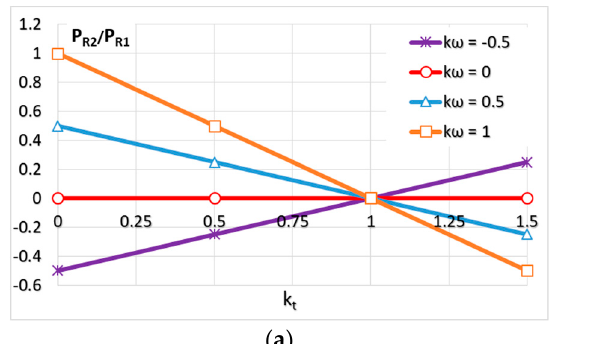
Figure 3. Reduced input power variations depending on the ratio k t for various values of ratio k ω :